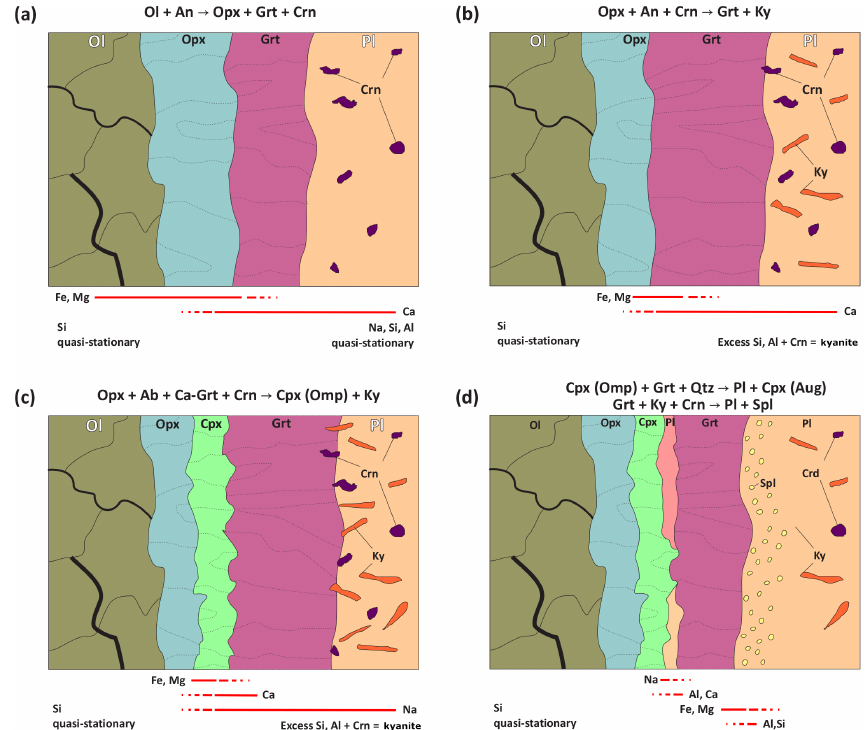
Figure 6. Multi-stage sequential corona layer development between plagioclase and olivine owing to varying component fluxes across the corona bands and, later, owing to decompression (modified after Indares, 1993). Corona layer growth in panels (a–c) occurs under constant high P and T , initially from discrete reactions between reactants and then subsequently between individual corona layers as component fluxes vary across the corona. The formation of the plagioclase layer in panel (d) is ascribed to decompression. Detailed reaction mechanisms are discussed in the